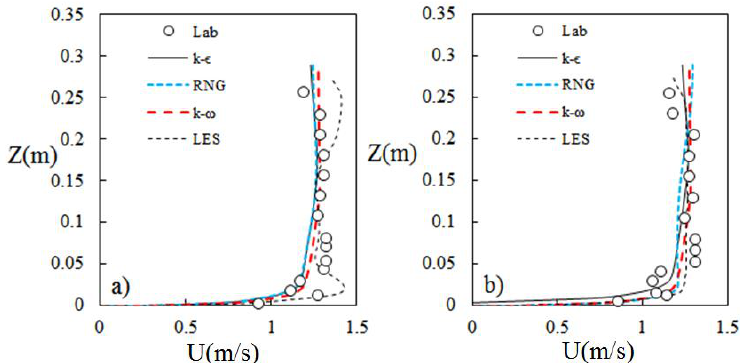
Figure 2. Velocity (U) calculations by various turbulence models at x = 8.82 (x* = 2 Wc) and ( a ) y = 0.25 Wc, and ( b ) y = 0.5 Wc.